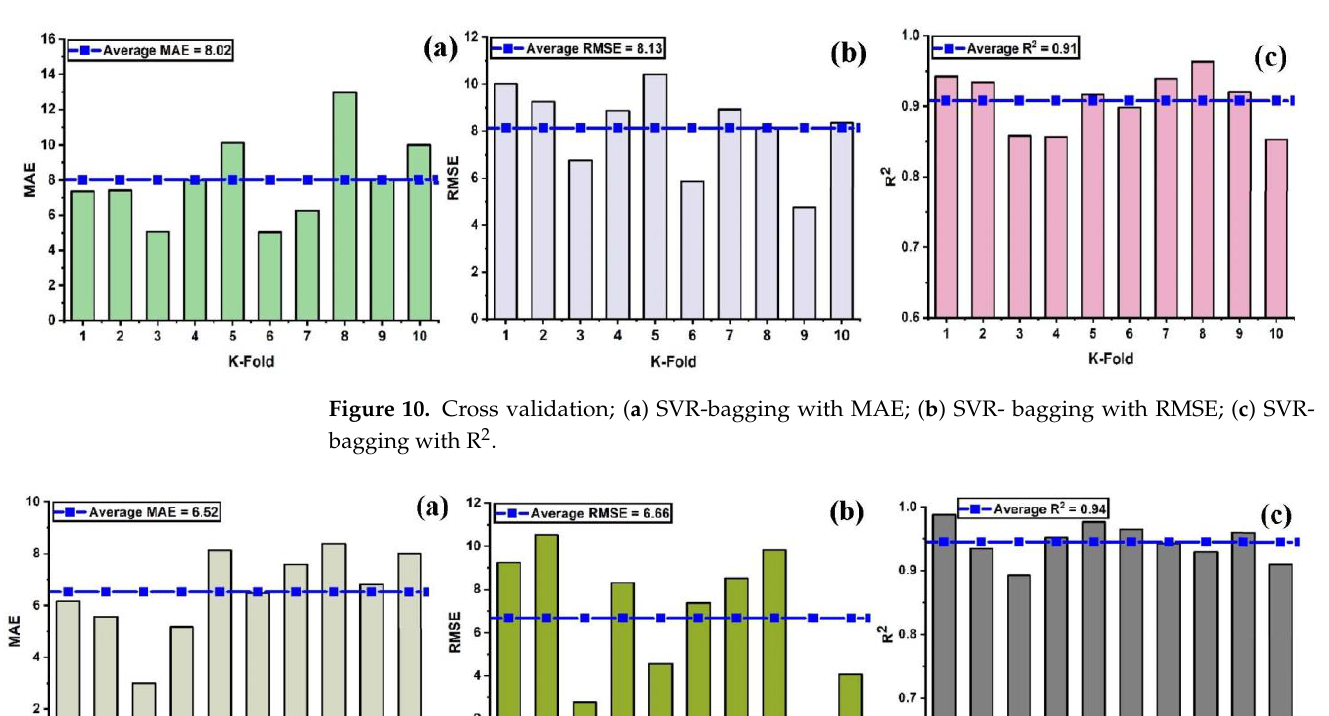
Figure 9. Cross validation; ( a ) SVR-adaboost with MAE; ( b ) SVR-adaboost with RMSE; ( c ) SVR- adaboost with R 2 .